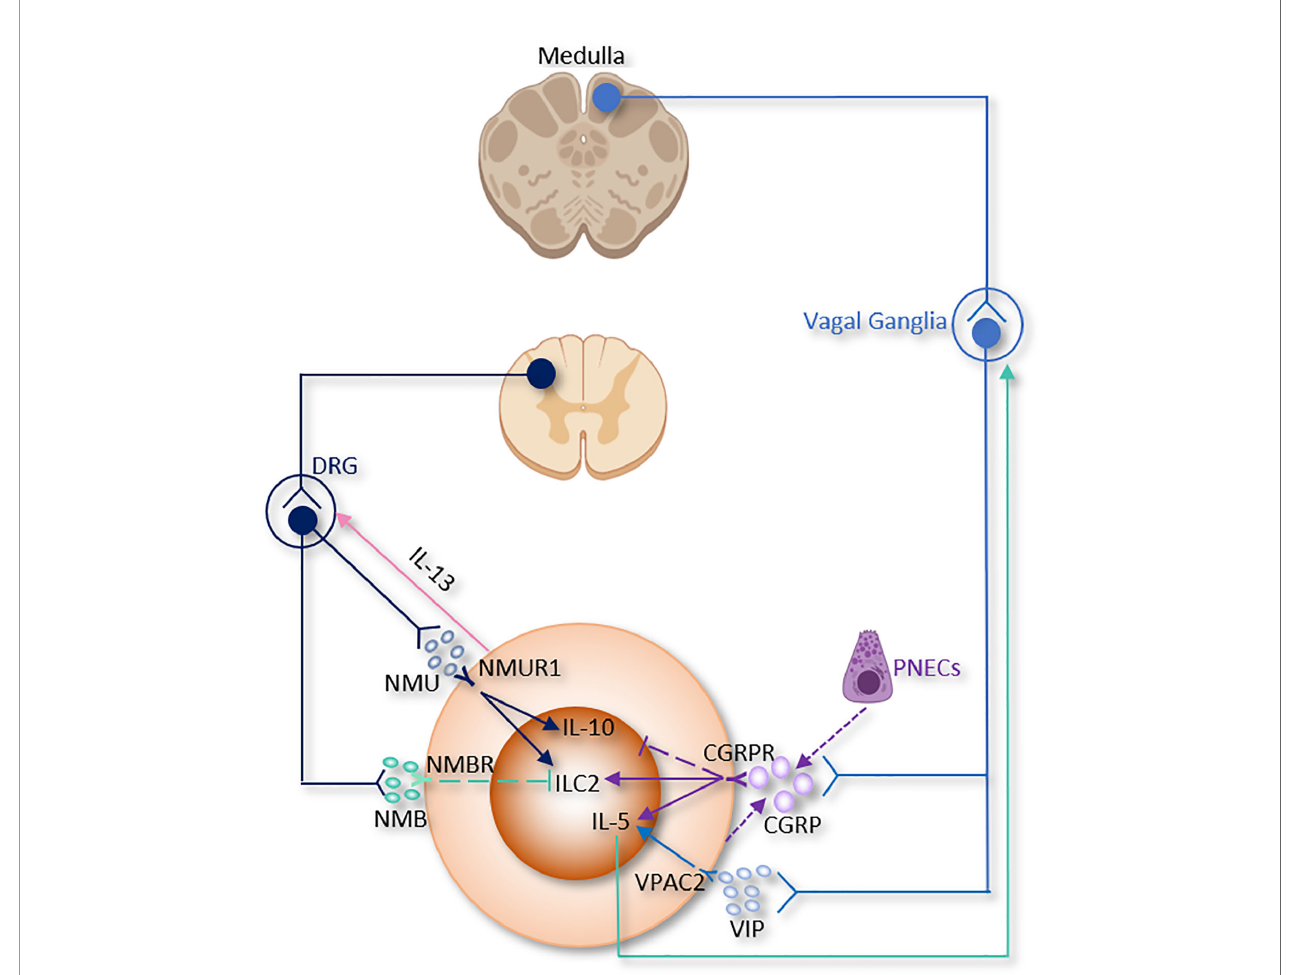
FIGURE 3 | The somatic nervous system regulation of ILC2 function. CGRP, a -calcitonin gene-related peptide; DRG, Dorsal root ganglion; NMB, neuromedin B; NMU, neuromedin U; PNECs, Pulmonary neuroendocrine cells; VIP, Vasoactive Intestinal